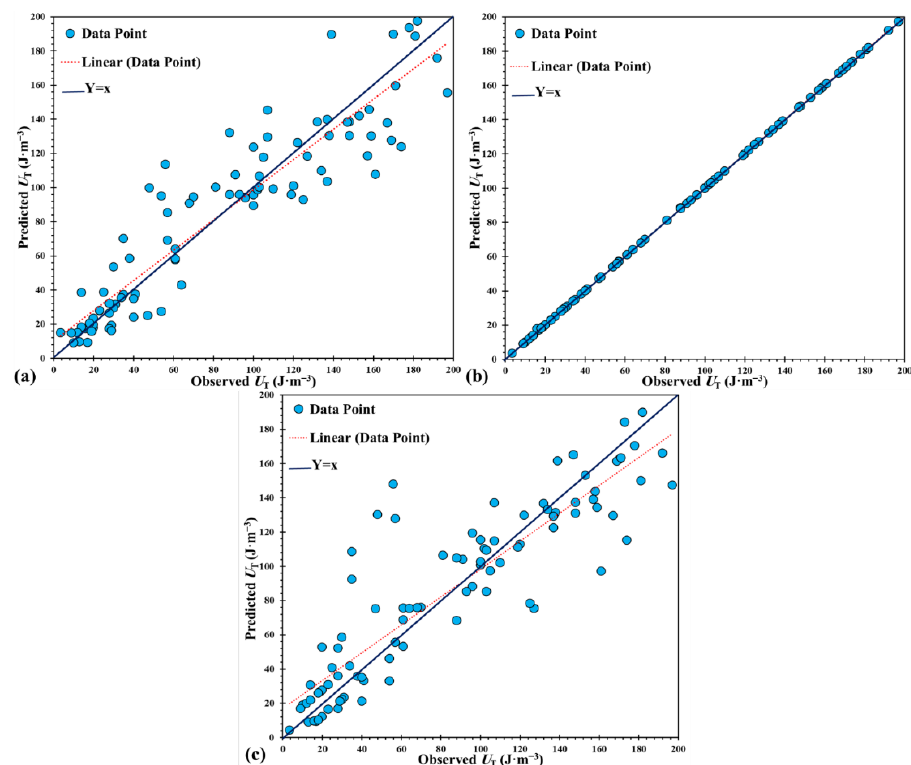
Figure 4. Correlation between the experimental and predicted hardness obtained by the model: ( a ) ANN, ( b ) ANFIS, and ( c ) SVR.